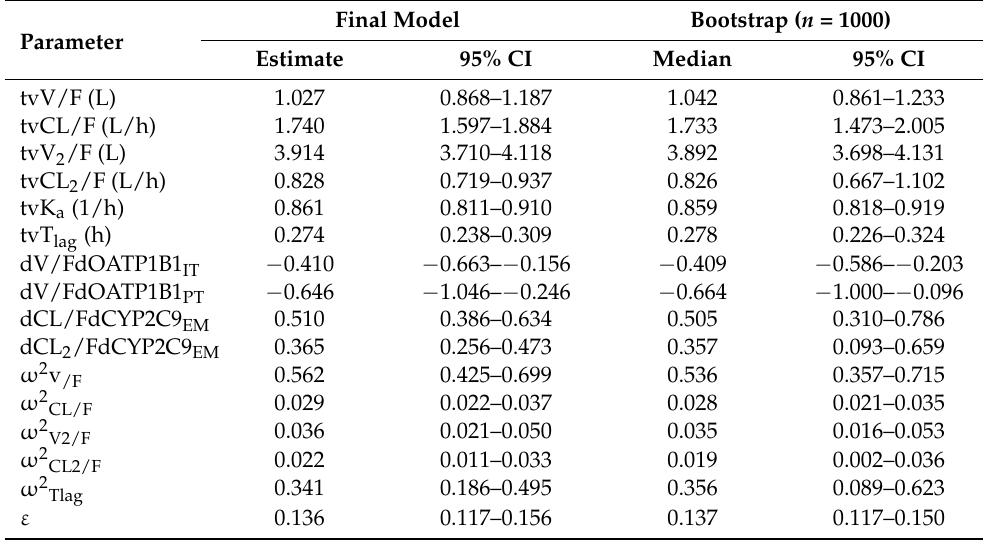
Table 5. Bootstrap results of the finally established human Pop-PK model for torsemide.